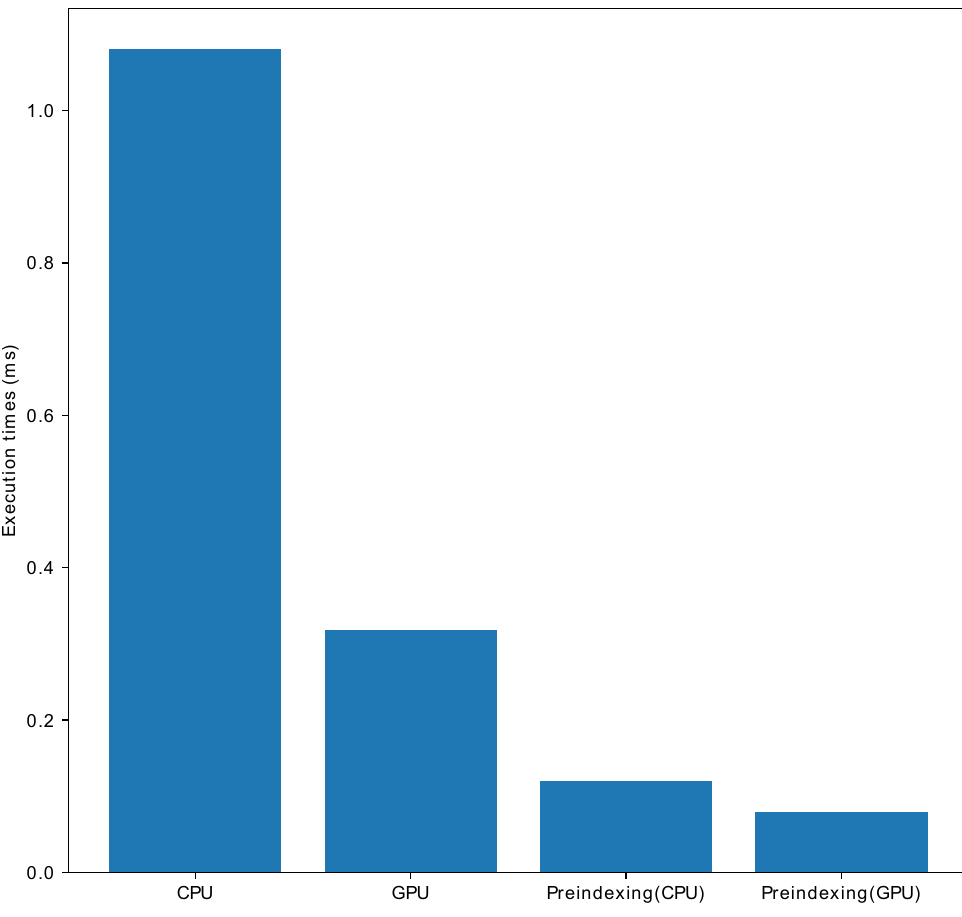
Figure 3. Pre-indexing for the fast image gradient ( ∇ and ∇ T ). The image gradient can be slow if image rolling is to be recalculated with each iteration. Pre-indexing can save the time needed for recalculation and image gradient during